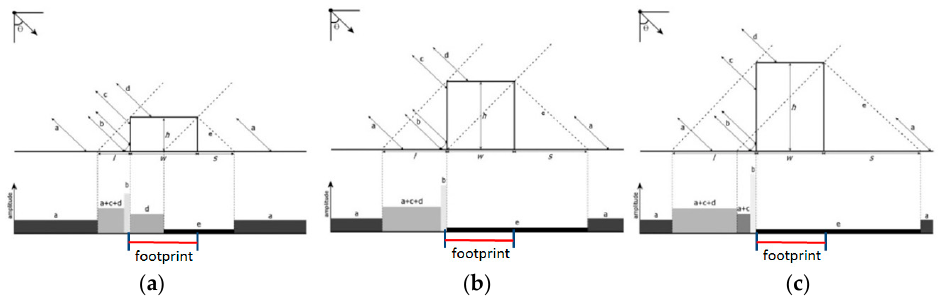
Figure 4. Backscattering range profiles from a simple flat roof building model with width w and different heights h . Ground scattering a , double bounce b , scattering from the vertical wall c , backscattering from the roof d and shadow area e are labeled. The gray values in the backscattering profiles correspond to the relative amplitudes. ( a ) h < w ·tan( θ ); ( b ) h = w ·tan( θ ); ( c ) h > w ·tan( θ ) (re-edited from [12]).